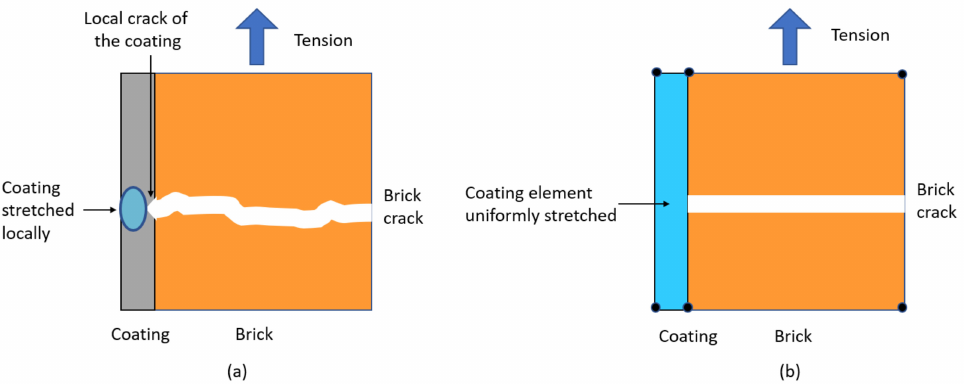
Figure 11. Comparison of the coating behaviour close to a crack in the experiment ( a ) and in the simulation ( b